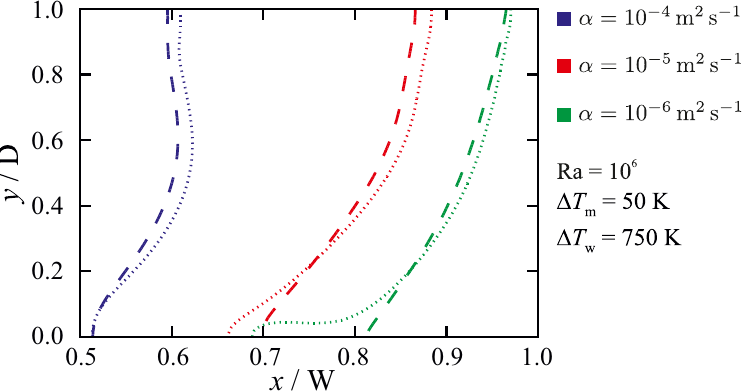
Figure 10. The influence of the permeability coefficient on predicted liquidus-line ( f L = 1) position for different melting-temperature ranges ∆ T m , at ∆ T w = 750K, and Ra = 10 6 . Dashed lines: C = 1 × 10 8 kgs − 1 m − 3 ; dotted lines: C = 1 × 10 4 kgs − 1 m − 3 . The results are given for Fo = 9, in which steady-state solutions are achieved.